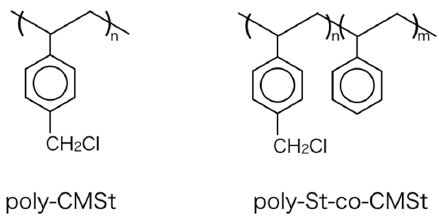
Figure 1. Structures of poly (p-chloromethyl)styrene and styrene/p-(chloromethyl)styrene random copolymer. The subscripts n and m represent the number of corresponding monomer units.